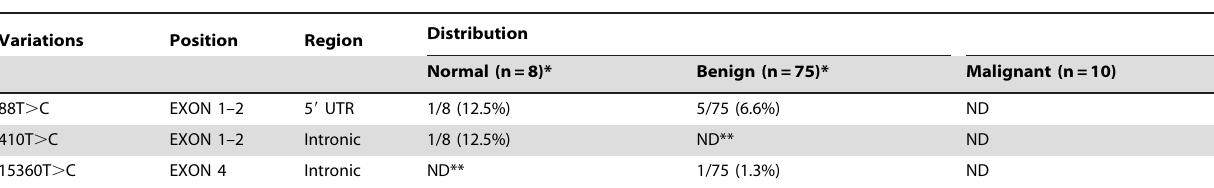
Table 2. Summary of sequencing changes in